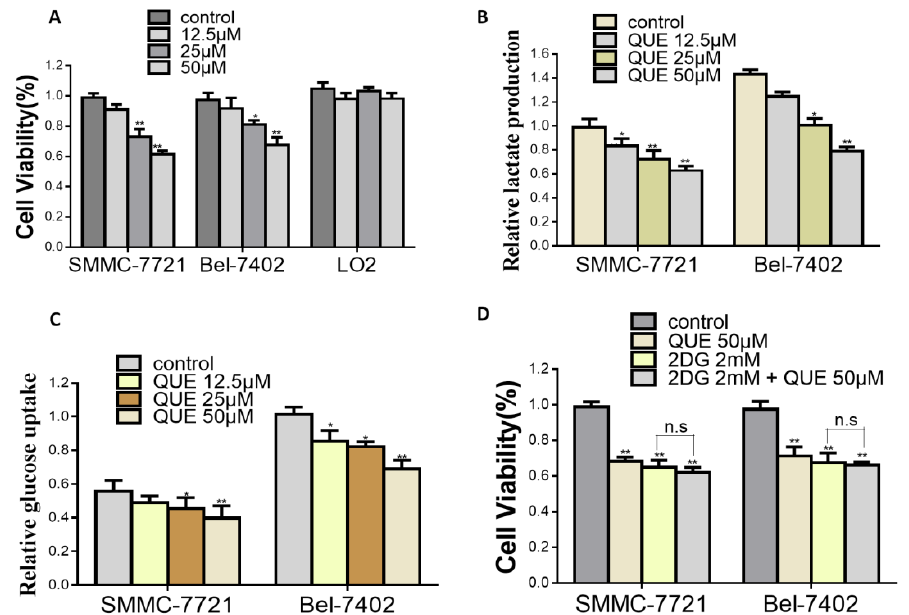
Figure 1. Inhibitory effects of quercetin (QUE) on cell viability and glycolysis in hepatocellular carcinoma (HCC) cells. ( A ) HCC cells were cultured with or without QUE (12.5, 25, and 50 µM) for 24 h and cell viability was detected through MTS[3-(4,5-diethylthiazol-2-yl)-5-(3-carboxymethoxyphenyl)-2-(4-sulfophenyl)-2H-tetrazolium, inner salt] assay. ( B , C ), The levels of lactate production ( B ) and glucose uptake ( C ) from HCC cell lines (SMMC-7721, Bel-7402) in the absence or presence of QUE at indicated concentrations for 24 h. ( D ) HCC cells were cultured in the presence of QUE, or 2DG or 2DG plus QUE at indicated concentrations for 24 h. Cell viability were detected. All experiments were performed in triplicate with similar results ( * P < 0.05; ** P < 0.01 versus control; n.s means no significance ).